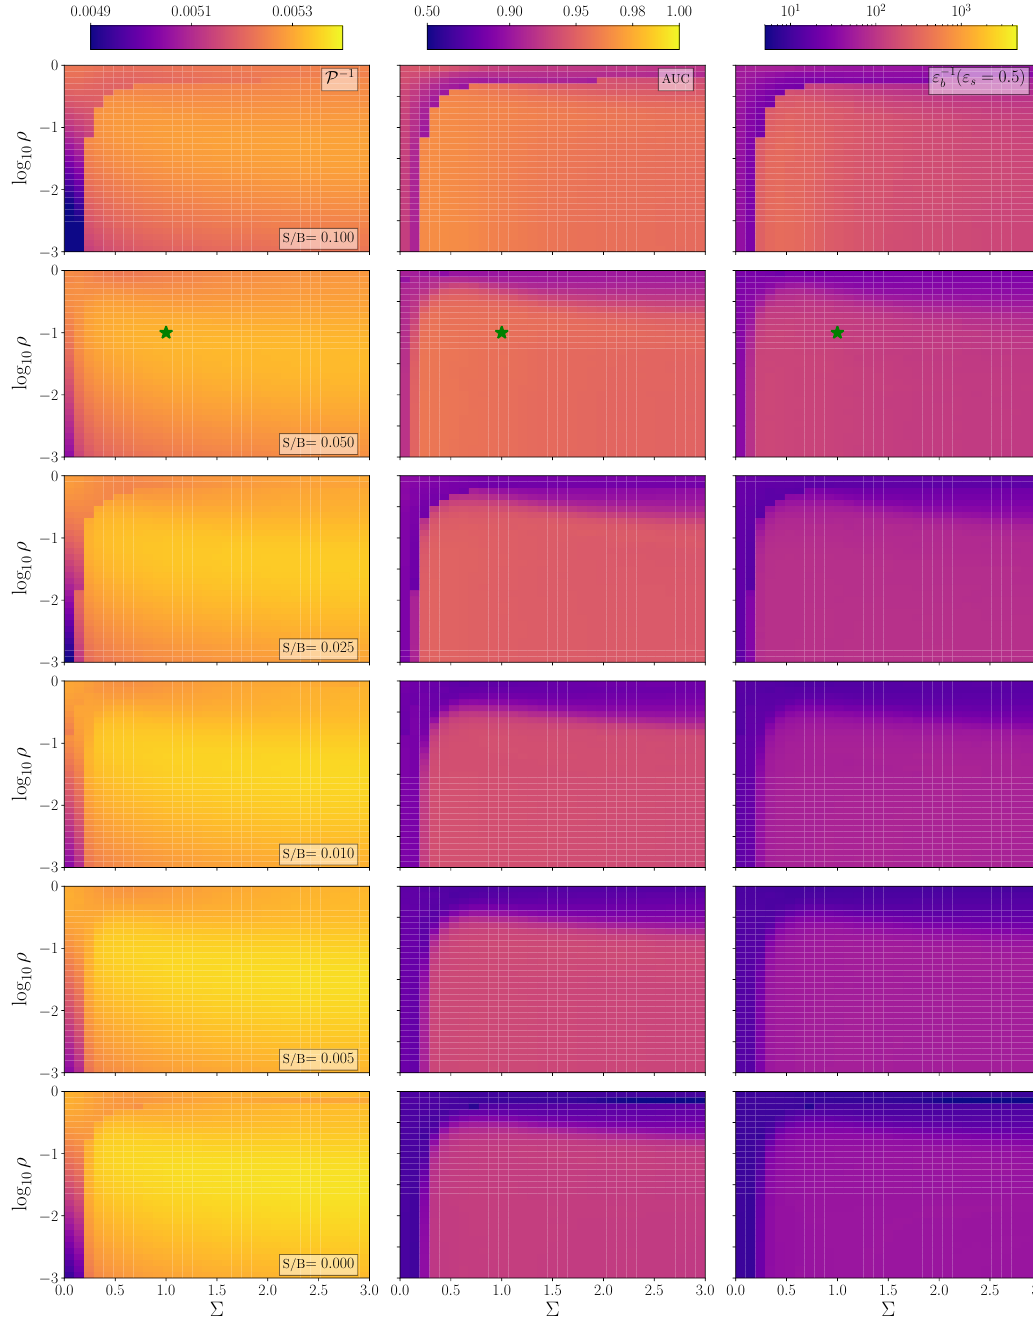
Figure 13 . Results of LDA models in the ( (cid:26); (cid:6)) parameter-space trained on samples of mixed W 0 and QCD events using Lund basis observables log k T and log R= (cid:1), with di(cid:11)erent S/B ratios (one per row). Each row contains plots of perplexity, AUC, and inverse mis-tag rate at (cid:12)xed e(cid:14)ciency (see text for details). The green star indicates the model used to plot the theme distributions in (cid:12)gure 14.